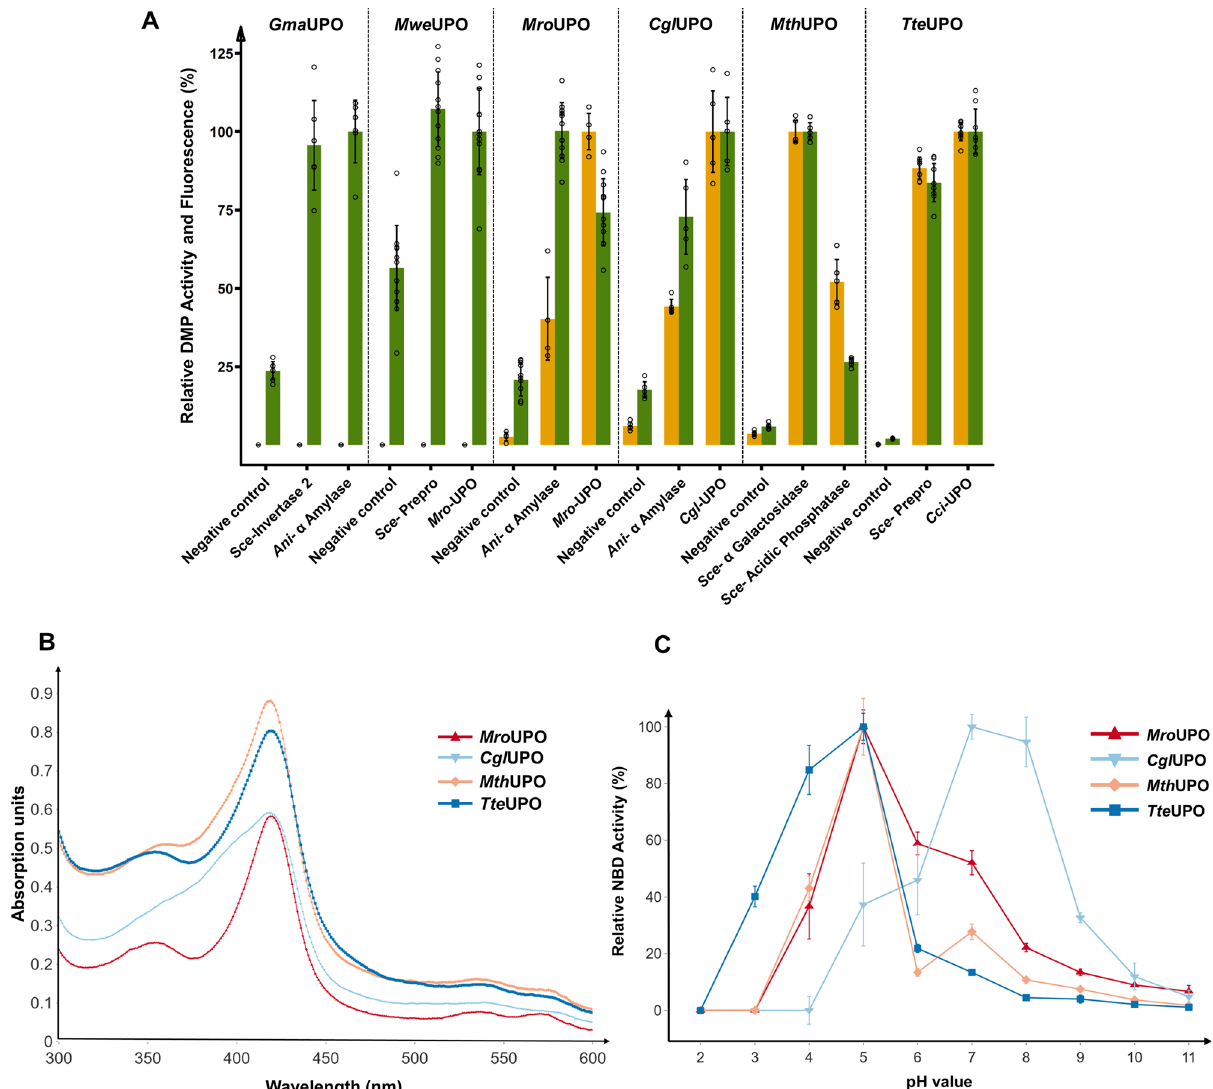
Fig. 2 Through signal peptide shuf fl ing identi fi ed novel UPO construct and their analysis of UV absorption spectra and pH pro fi les. A Golden Gate signal peptide shuf fl ing was applied for the testing of described and putative UPO genes, and the two best signal peptide/UPO gene combinations are displayed. Gma UPO, Mwe UPO, Mro UPO and Cgl UPO were screened in combination with a GFP11-tag. Mth UPO and Tte UPO were screened using the TwinStrep-GFP11 protein tag. UPO enzyme activity was determined by monitoring the conversion of 2,6-dimethoxyphenol (DMP) to coerulignone. The highest average fl uorescence (split-GFP) and conversion values (DMP) within one enzyme panel were set to 100%, and the other values normalised accordingly. Data are mean±s.d. of biological replicates ( n ≥ 4). Corresponding primary data are displayed within the Source data fi le. B UV-Vis absorption spectra of the puri fi ed peroxygenases Mro UPO, Cgl UPO, Mth UPO and Tte UPO in the wavelength range between 300 and 600nm (measurement interval: 1nm). C pH pro fi les of Mro UPO, Cgl UPO, Mth UPO and Tte UPO catalysed enzymatic conversion of 5-nitro-1,3-benzodioxole (NBD) to 4-nitrocatechol. The highest mean activity of a respective enzyme was set to 100% and the other values normalised accordingly. Data are means±s.d. of measurements performed in triplicates. Corresponding primary data are displayed within the Source data fi